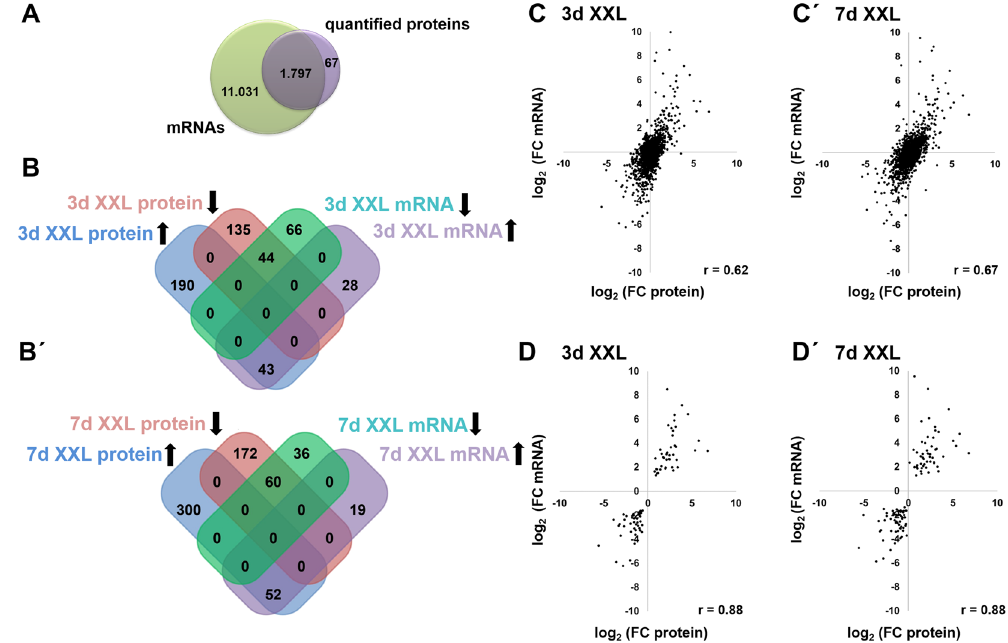
Figure 3. Comparison of mRNA- and proteome data in USSC and XXL-USSC. ( A ) Coverage of mRNA and protein data. From all quantified proteins, 96% were also found in the transcriptome. To exclude non-coding RNAs from the NGS data, only identified transcripts known to encode proteins were included here as revealed by UniProt database. ( B , B’ ) Significantly regulated genes and significantly regulated corresponding proteins at 3d ( B ) and 7d ( B’ ) of XXL incubation. Black arrows denote the regulatory direction. ( C , C’ ) Correlation of mRNA- and corresponding protein regulation at 3d XXL ( C , Pearson correlation coefficient 0.62) and 7d XXL ( C’ Pearson correlation coefficient 0.67) compared to expression levels in native USSC, respectively. ( D , D’ ) Correlation of significantly regulated mRNAs and corresponding proteins at 3d XXL ( D , 89 mRNAs, Pearson correlation coefficient 0.88) and 7d of XXL incubation ( D ’, 112 mRNAs, Pearson correlation coefficient 0.88) compared to expression levels in native USSC,